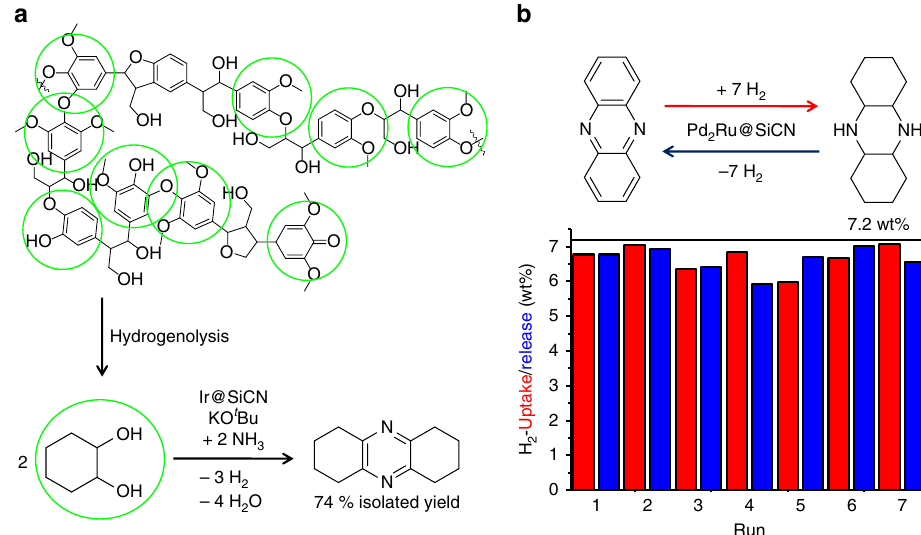
Figure 3 | Sustainable synthesis of octahydrophenazine from cyclohexanediol and ammonia and its use as a reversible hydrogen carrier. ( a ) A section of the lignin structure with alkoxybenzene subunits marked by green circles (top). Lignin can be converted to cyclohexane-1,2-diol using existing methodologies (hydrogenolysis). Synthesis of octahydrophenazine from cyclohexane-1,2-diol and ammonia (bottom). ( b ) Catalyst reusability and reversible hydrogen storage with phenazine: 360mg (2mmol) phenazine, 70mg Pd 2 Ru@SiCN (0.36mol% active metal). Hydrogenation: 115 (cid:2) C, 50bar H 2